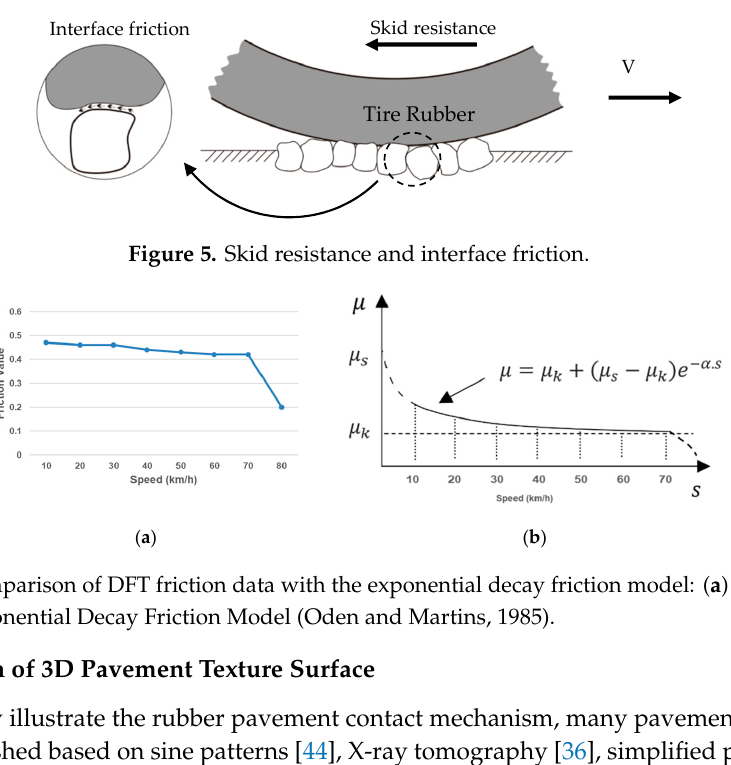
Figure 5. Skid resistance and interface friction.